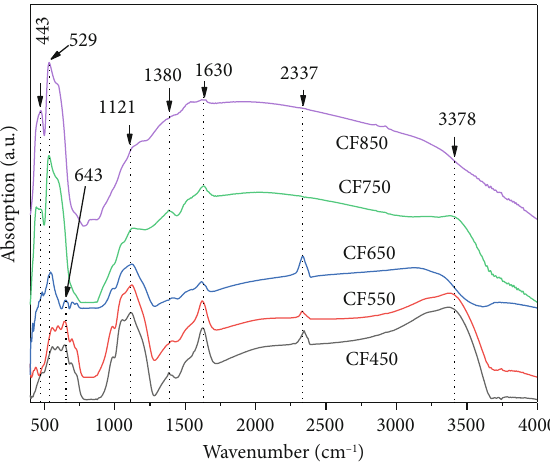
Figure 2: FTIR spectra of gel samples with the CF/TA ratio of 1 :3 calcined at di ff erent temperatures for 2